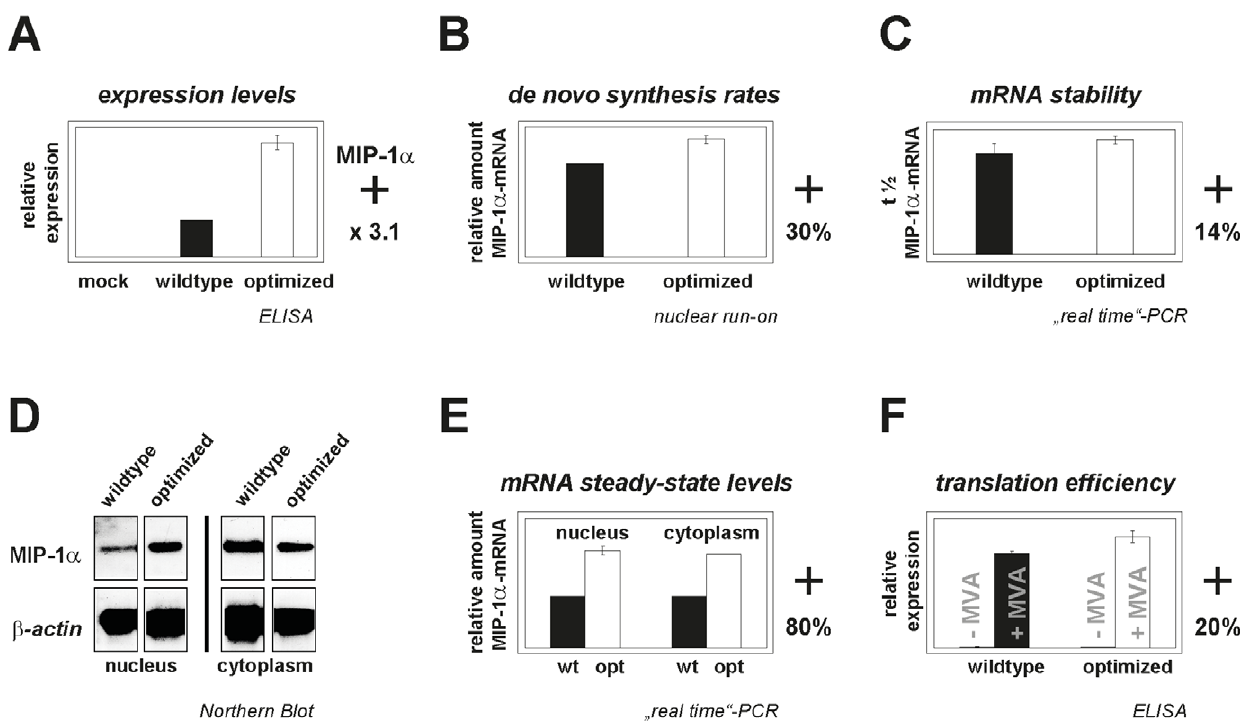
Figure 3. Influence of sequence optimization on expression-related mechanisms acting on stably integrated mip1 a genes. (A) Relative protein expression levels of wildtype or optimized mip1 a genes stably expressed in CHO-K1 cells were calculated from the mean values* measured by ELISA. (B) De novo transcription of RNA was measured by nuclear run-on assays. Cell nuclei were incubated with biotin-16-labeled dUTPs, separated via streptavidin-labeled magnetic beads, reverse-transcribed, and the resulting cDNAs were quantified by real-time PCR. De novo synthesized mip-1 a transcripts* were normalized to hph cDNA levels, and the wildtype value* was set to 100%. (C) To determine mRNA stability both cell lines were incubated with 2.4 m M Actinomycin D for 0, 1.5, 3, 6, 12 and 24 hours. Total RNA was extracted at the respective time points and mip- 1 a mRNA levels quantified by real-time PCR were standardized against hph- specific mRNA amounts to obtain relative mip-1 a mRNA half-lives of wildtype and optimized genes*. (D) Nuclear or cytoplasmic mip-1 a mRNAs (2 m g) were subjected to Northern blot analysis using a DIG-labeled probe hybridizing to the BGH-polyA signal. Beta-actin served as an internal loading control. (E) Total RNA was separated from nuclear and cytoplasmic fractions, reverse-transcribed, and subjected to quantitative SYBR-Green real-time PCR using specific primers for both gene variants and the hph gene internal control. The resulting mip-1 a cDNAs were verified by sequencing and amounts were standardized to hph cDNA levels to obtain mean mRNA steady-state values*. (F) To determine translation rates, HEK293T cells were infected with MVA-T7 prior to transient transfection with mip-1 a variants under the control of a T7-promoter ( + MVA). Transfected but uninfected cells served as negative controls (-MVA). Protein levels in cell supernatants were determined 24 hours post-transfection by ELISA. Expression levels obtained from wildtype transfections of infected cells were set to 100% and values from optimized genes were calculated accordingly. *Mean values derived from 2 independent experiments. + indicates relative improvements due to gene